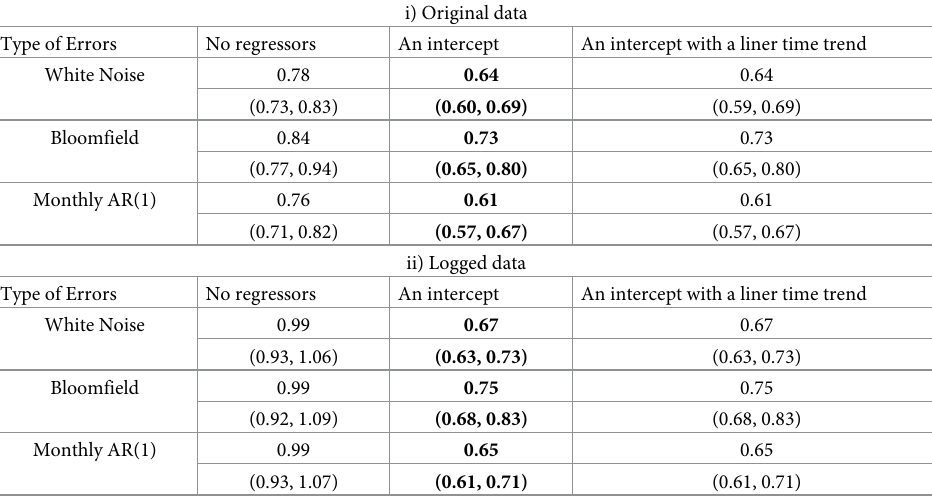
Table 3. Estimates of the differencing parameter: 1976m1 – 2020m2.